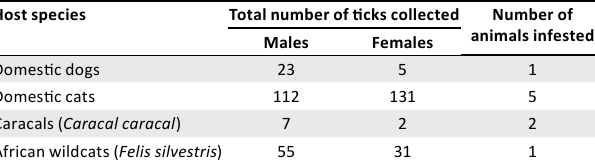
animals infestedMales Females